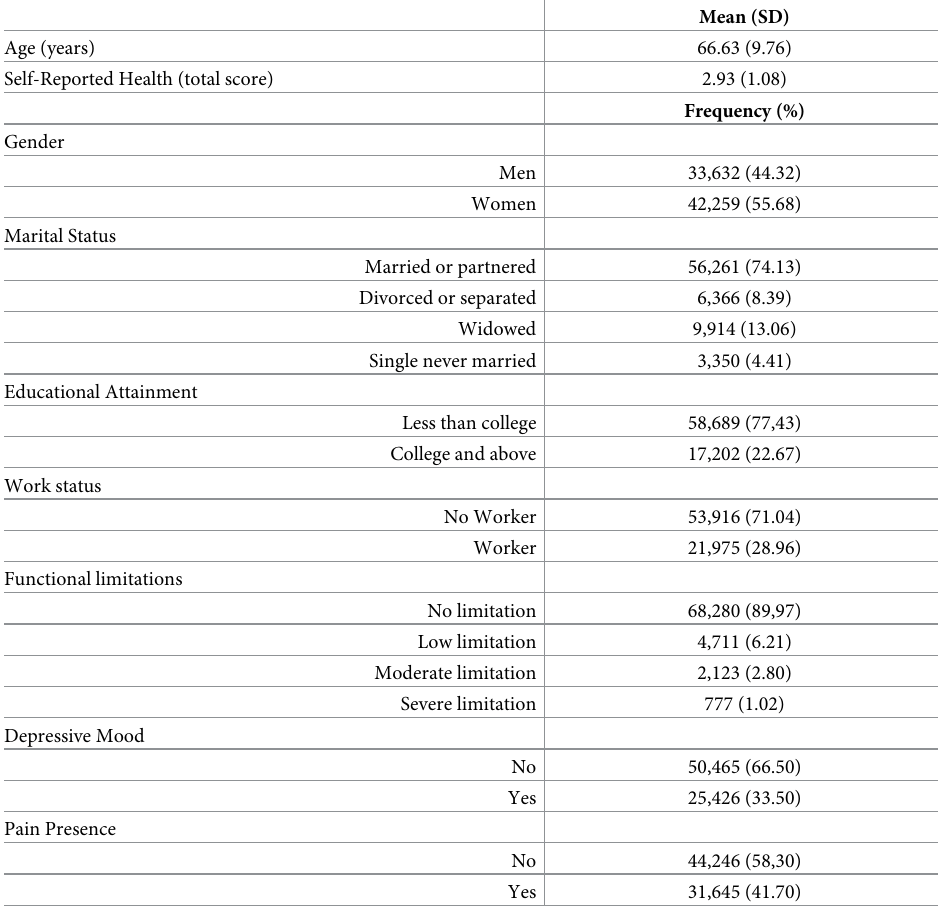
Table 1. Participants sociodemographic and health characteristics (N =